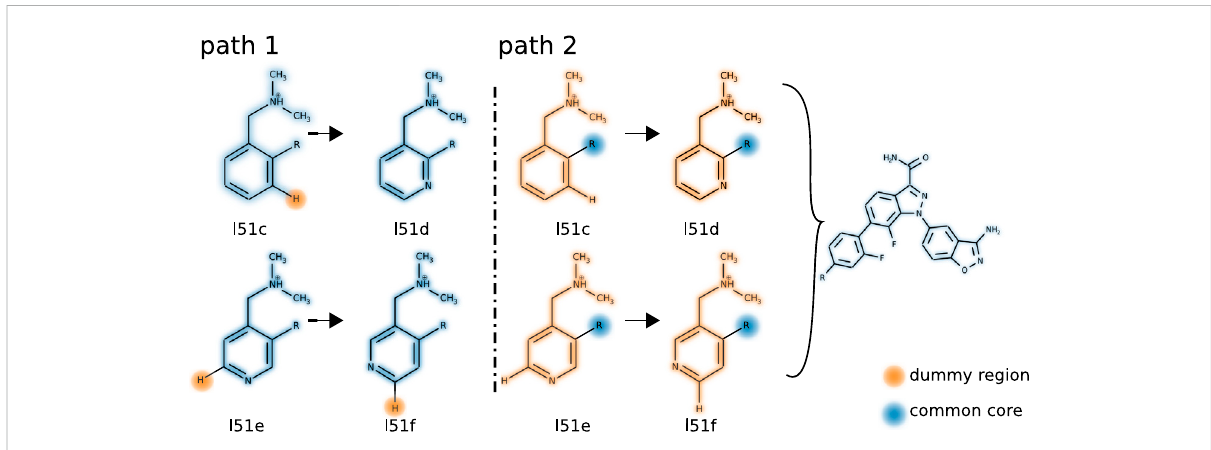
FIGURE 4 Thetwopathwaysforcalculating ΔΔ G bind (l51c → l51d)and ΔΔ G bind (l51e → l51f)oftheFXadataset.Path1:onlyasinglehydrogenismutatedinto adummyatom(l51c,andl51e,l51f);then,aspartofmakingtheCCequivalent,thecarbonitisboundtobecomesanitrogenatom(l51dandl51f).Path 2: the dummy region encompasses the compete aromatic ring plus the dimethylammoniomethyl